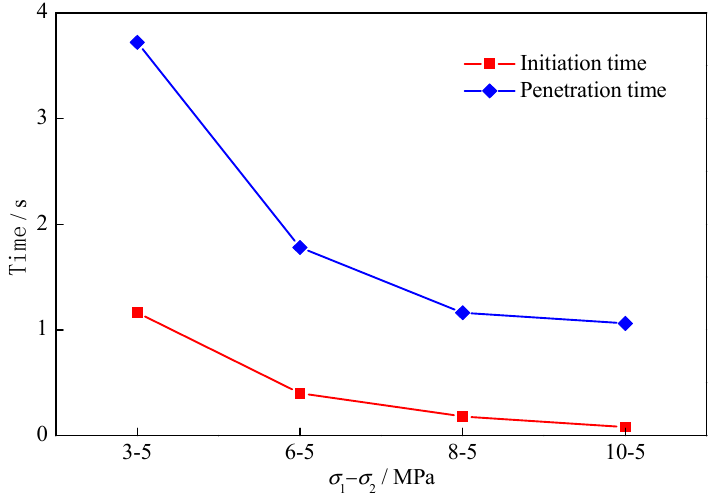
Figure 3. Initiation and penetration times of hydraulic fractures under different stress differences.